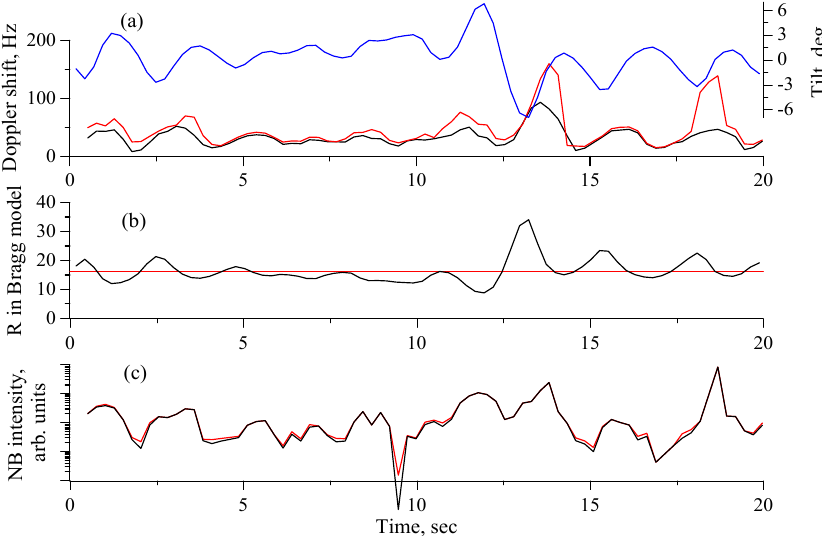
Figure 9. An example of a retrieval of a non-Bragg component showing: Doppler shift of the polarization difference (black curve), non-Bragg component (red) and tilts of the long waves (blue) ( a ); the local polarization ratio in a two-scale Bragg model (black) and mean PR (red) ( b ); and non-Bragg components of radar return when we did and did not take the local angle of the surface local tilts into account ( c , black and red curves, respectively).